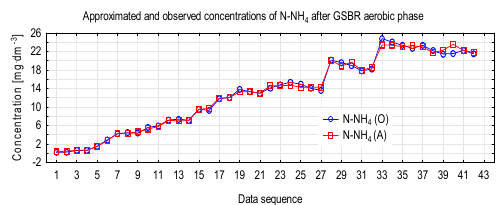
Figure 4. Approximated and observed concentrations of N-NH 4 after sequence bath reactor with aerobic granular activated sludge (GSBR) aerobic phase.